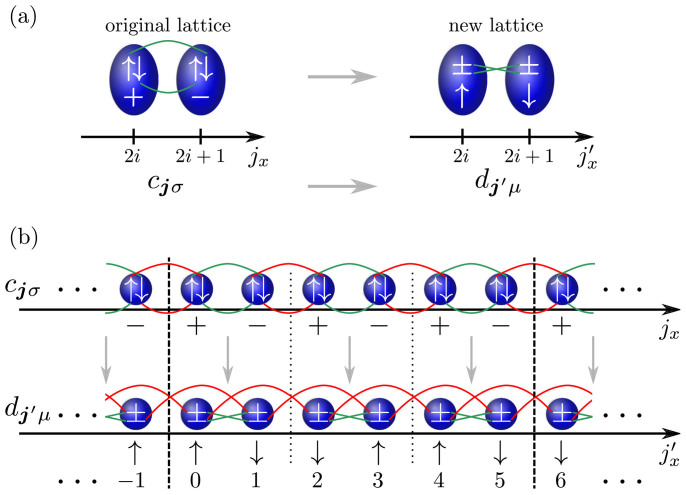
Twisting the Hubbard interaction.Part (a) shows the relabeling of the spin σ and spatial even/odd site μ degrees of freedom. To obtain an identical Hamiltonian H2D + Hz one must realize different hopping elements between nearest and next-nearest neighbor sites as illustrated in (b) for the x-direction. The required hoppings along the y- and z-direction are described in detail in Supplementary Discussion S2.